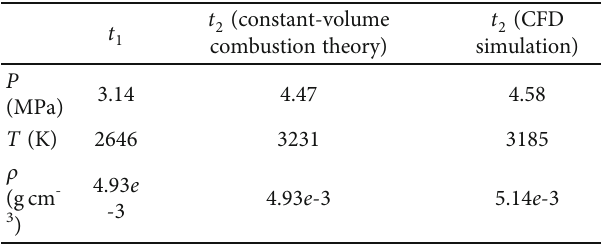
Table 4: The comparison of constant-volume combustion theory results and CFD simulation results.